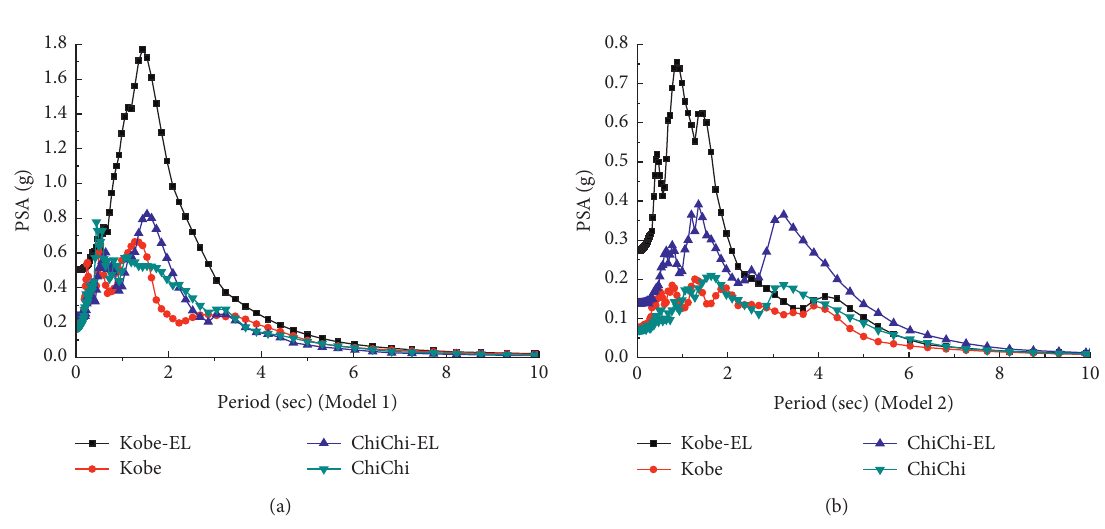
Figure 8: Surface response spectra of (a) model 1 and (b) model